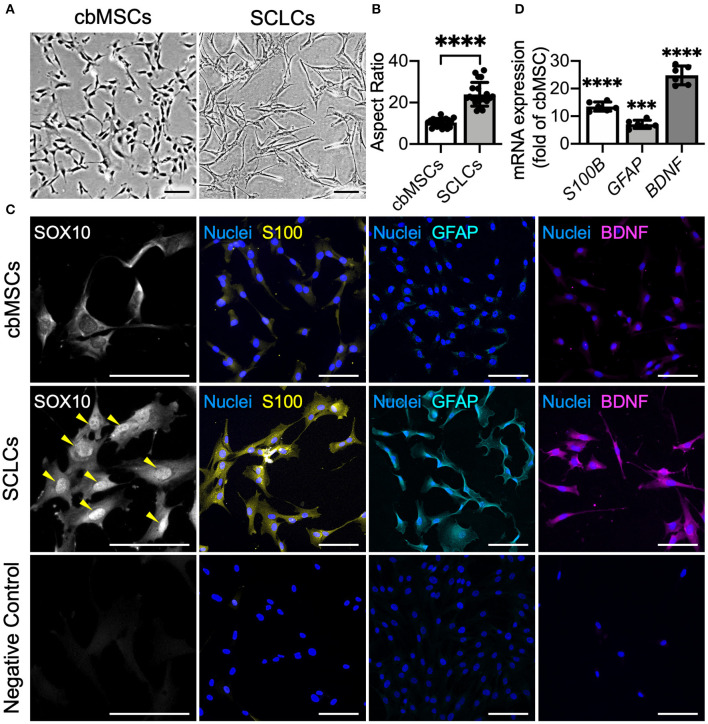
Umbilical cord blood mesenchymal stem cells (cbMSCs) are converted into Schwann cell (SC)-like cells (SCLCs) using a non-genetic approach. (A) Morphological characteristics of the cbMSCs before and after being converted into SCLCs and (B) their corresponding aspect ratios (n = 20 cells pooled from 2 independent experiments, mean ± s.d.) ****P < 0.001. (C) Expression of SC markers SOX10, S100, and GFAP and neurotrophic factor BDNF by cbMSCs and cbMSC-derived SCLCs detected by immunofluorescence staining or (D) determined by real-time quantitative polymerase chain reaction. The results are expressed as the fold change relative to the undifferentiated cbMSCs (n = 6 pooled from 3 independent batches of differentiation, mean ± s.d.). Samples immunostained without primary antibodies were used as negative controls. Arrow heads indicate nuclear accumulation of SOX10. Scale bars: 100 μm. ***P < 0.005 vs. undifferentiated cbMSCs. ****P < 0.001 vs. undifferentiated cbMSCs.